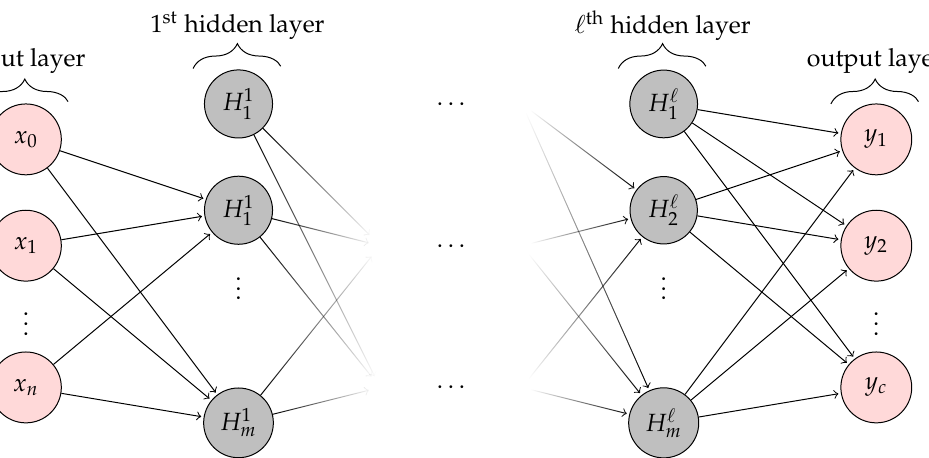
Figure 5. Structure of a classical artificial neural network. The model shows how each neuron in a network can be implemented. This example is for data from three input features.